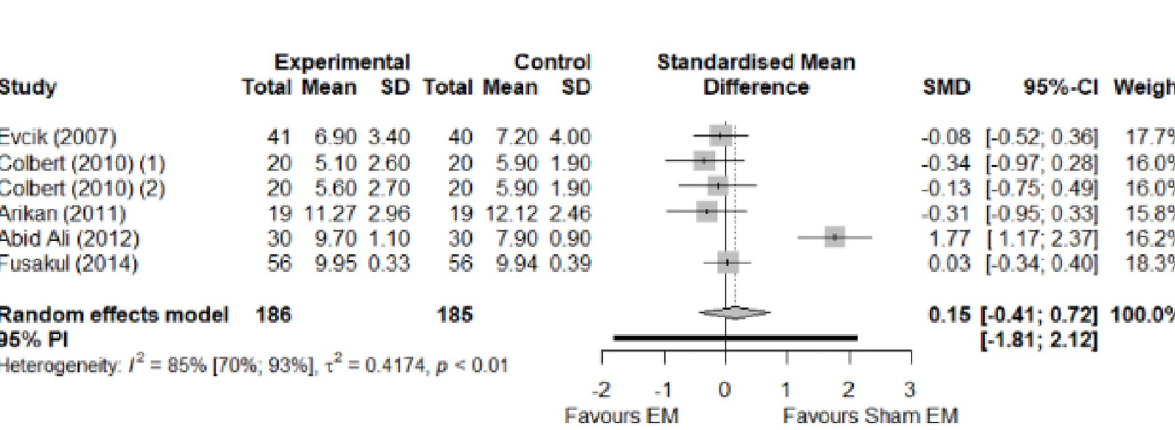
Fig 10. Analysis—Electrophysical modalities versus placebo (compound muscle action potential amplitude). Studies with more than two intervention groups (different modalities, treatment doses, or symptom classification) were numbered as (1) and (2).